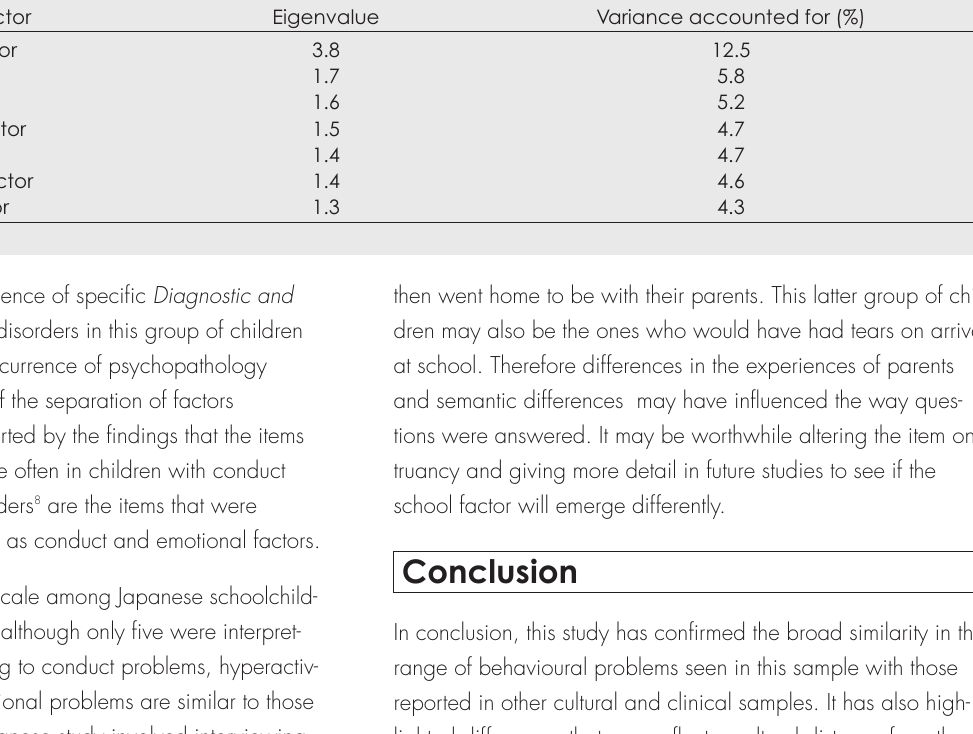
Table II. Eigenvalues and variance for seven interpretable factors Name and number of